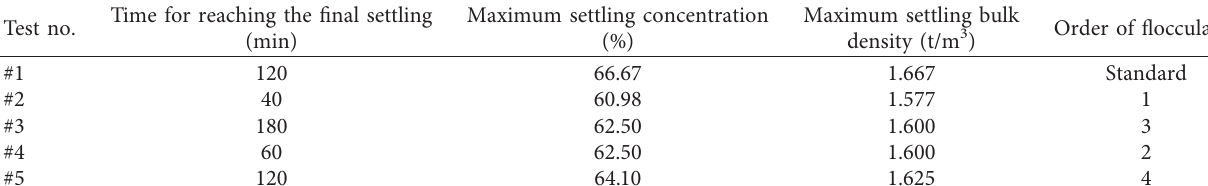
Table 3: Statistics on parameters at final settling.